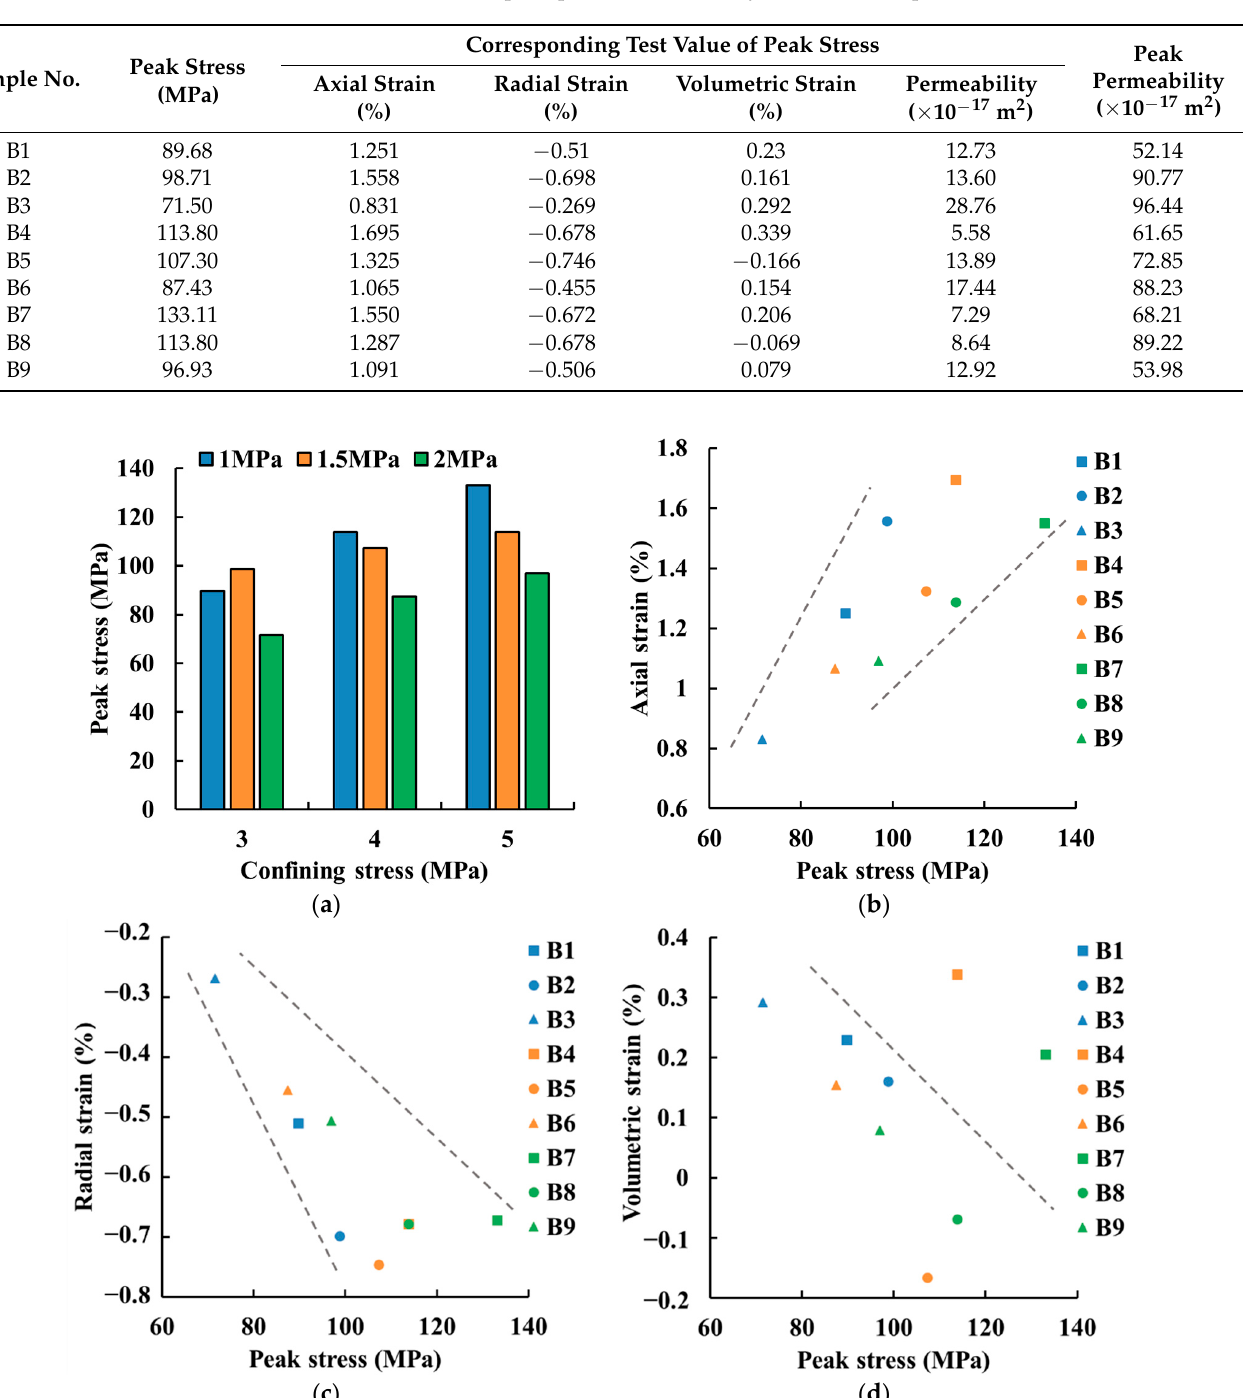
Table 2. Information of peak parameters of sandy mudstone sample.